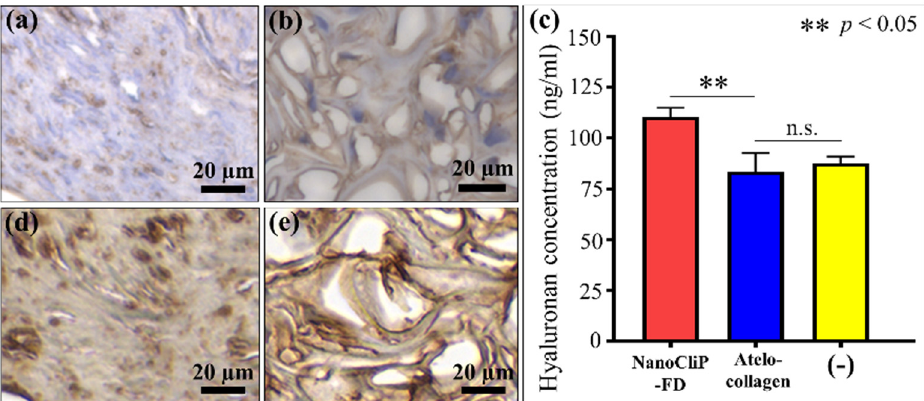
Figure 3. Light microscopy images of biotinylated hyaluronan-binding protein staining of cartilage tissue grown in CM onto ( a ) NanoCliP-FD gel and ( b ) atelocollagen scaffolds; ( c ) ELISA measurements to determine the soluble hyaluronan supernatant concentration at 14 days of culture (statistical results of Student’s t- test showed significance between data collected on different scaffolds; the abbreviation n.s. means non-significant); ( d , e ) show light microscopy images are shown of stained type II collagen in the cartilage tissue grown in CM onto NanoCliP-FD gel and atelocollagen, re- spectively.